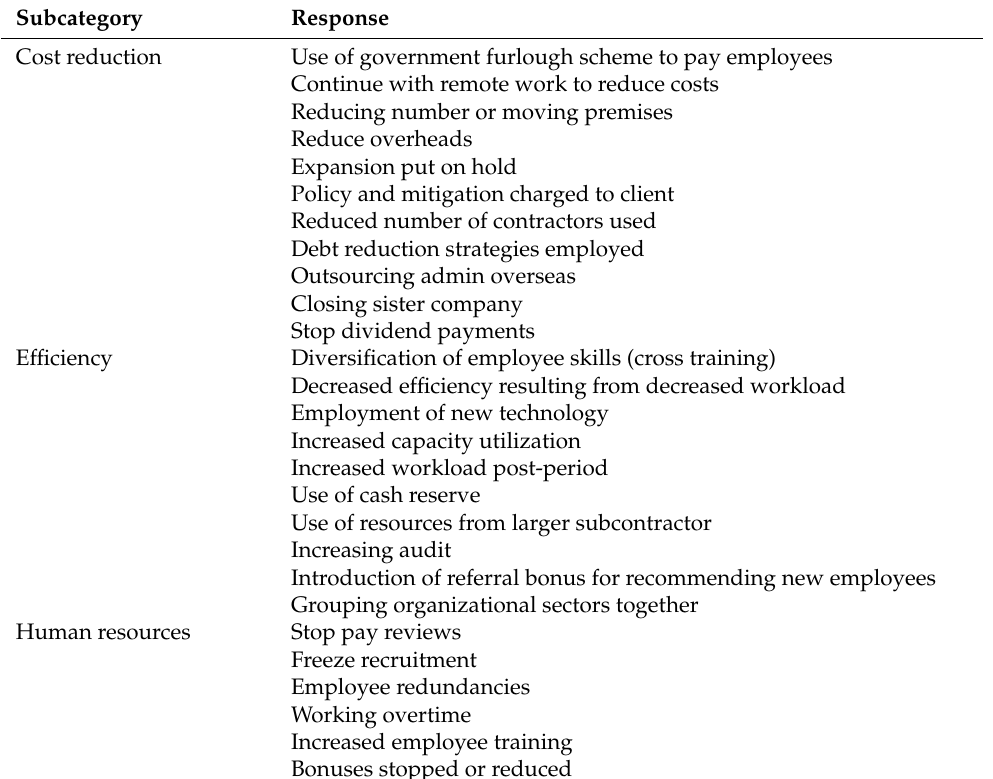
Table 3. Cost-related